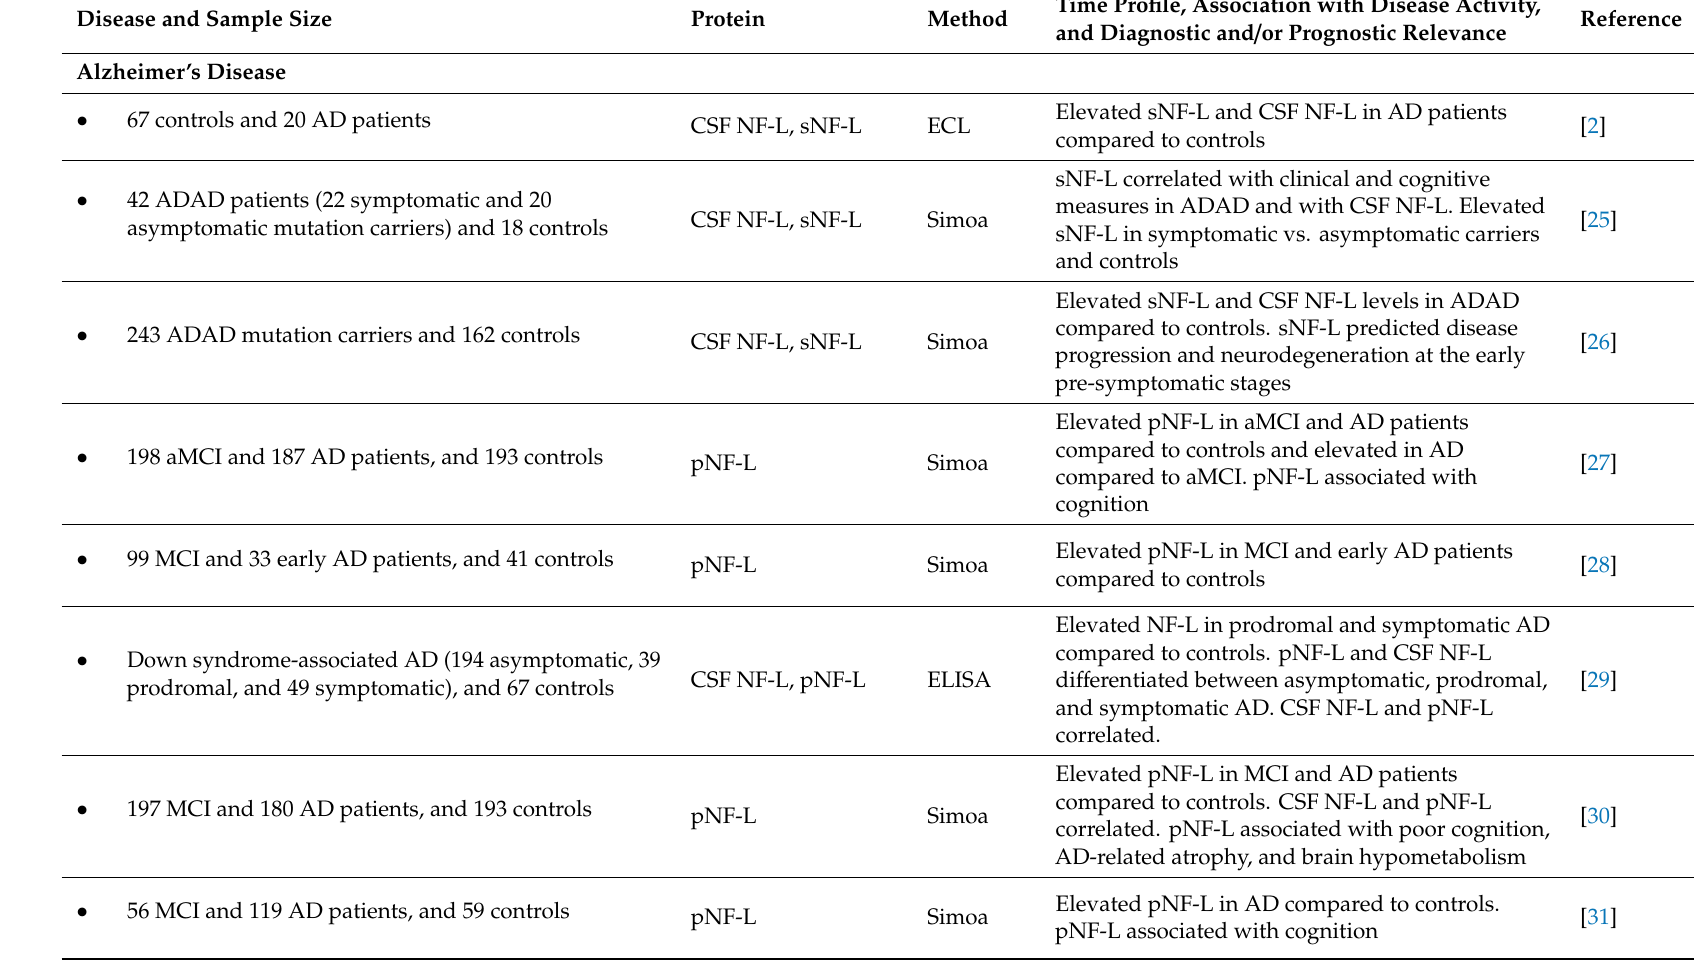
Table 1. Cont. Time Profile, Association with Disease Activity, and Diagnostic and / or Prognostic Relevance